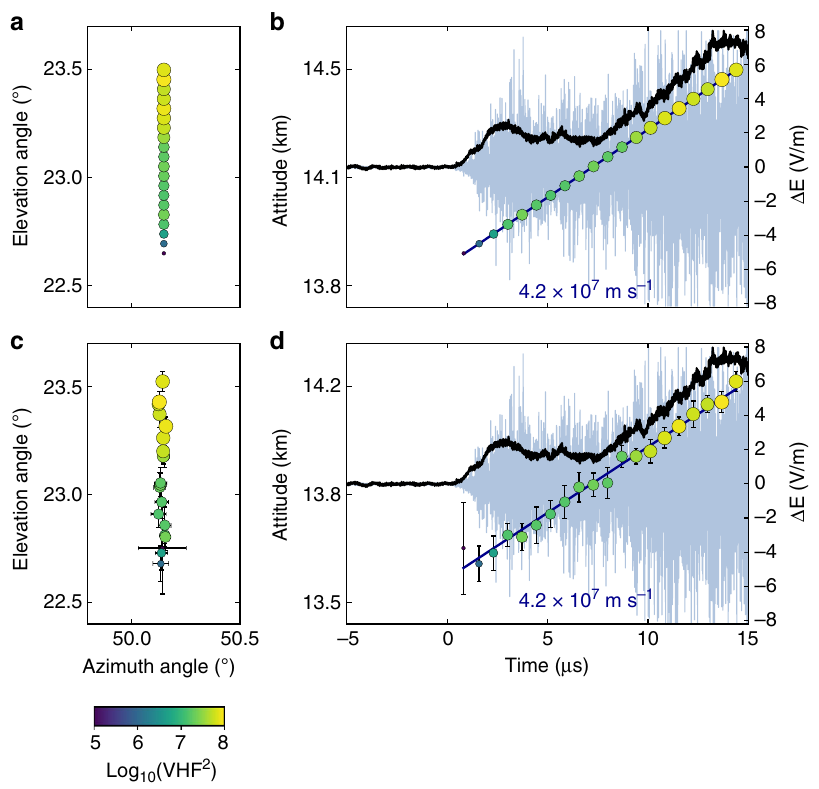
Fig. 6 NBE 2 simulation. Simulated radiation centroids (circular markers, colored and sized by VHF power) of a vertically propagating point source, having the same VHF amplitudes, altitudes, and speed of NBE 2. Each marker denotes the average angular position of the 128 source solutions in each 0.7- μ s window, and error bars denote the standard deviations. a , b Centroid locations without added noise, plotted in elevation vs. azimuth and elevation vs. time, respectively, and c , d same, but with the pre- fl ash noise of NBE 2 added, showing that the resulting scatter in elevation and azimuth is partially but not fully accounted for by the pre- fl ash